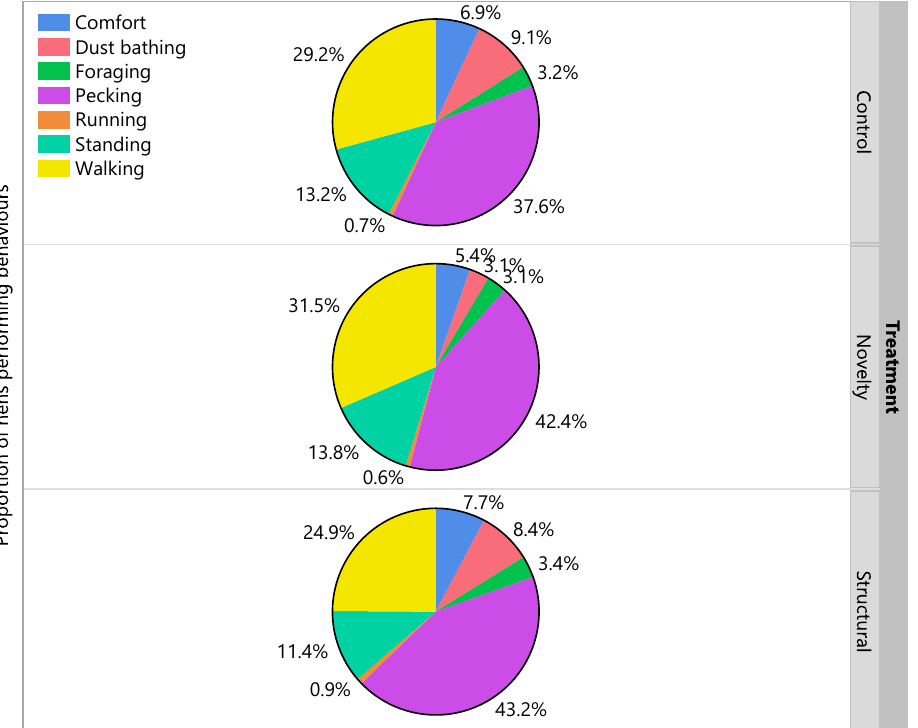
Figure 7. The percentages of hens on a portion of the range performing comfort behaviors, dust bathing, foraging, pecking, running, standing and walking across three different rearing treatments (control, novelty, structural). Observations were made when hens were 50 weeks of age across two days.